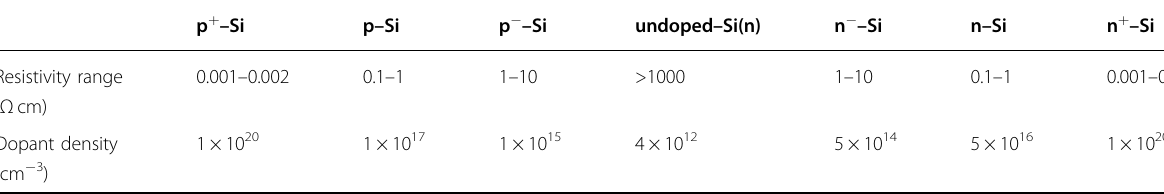
Table 3 Properties of the Si samples in the